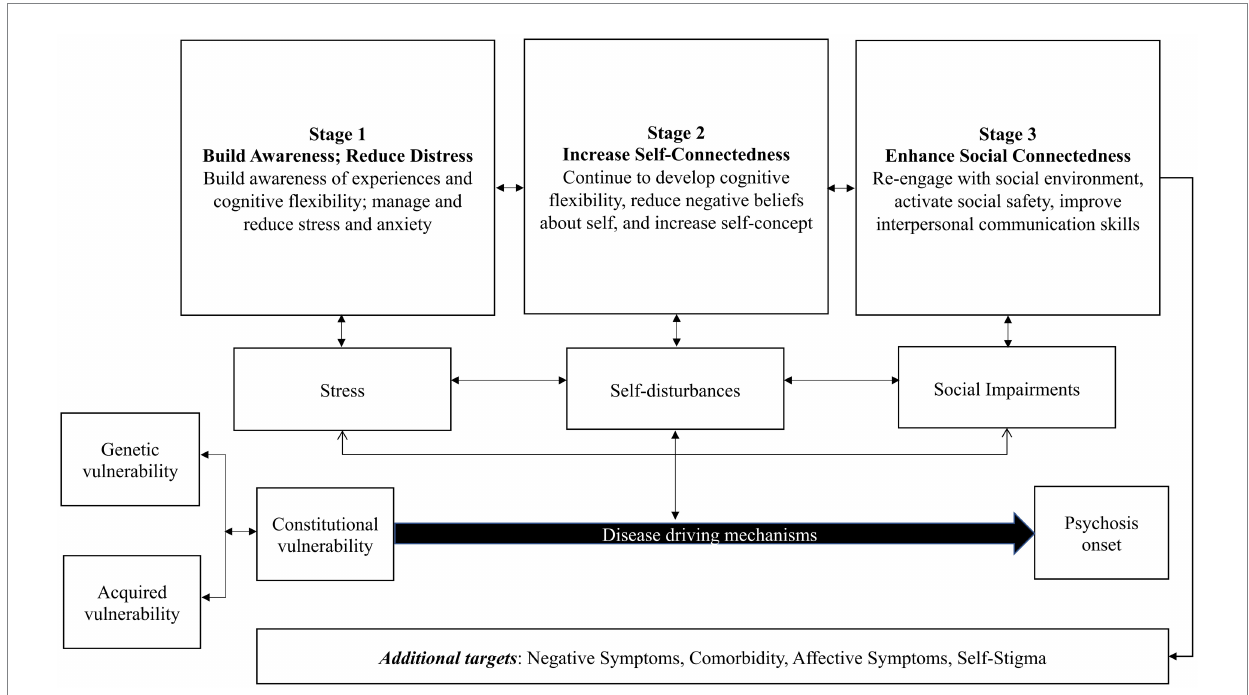
FIGURE 1 SPACE group conceptual model. The diathesis stress model posits that the onset of psychotic disorders such as schizophrenia can occur through the interaction between genetics and acquired vulnerability. This interaction can lead to a constitutional vulnerability, the diathesis, that can further interact with stress, self-disturbances, and social impairment, possible disease driving mechanisms (amongst others not listed here due to the focus of the framework). The conceptual framework suggests taking an integrative approach to group therapy by targeting stress, self-disturbances, and social impairments could be useful. Furthermore, integrating skills from standard Dialectical Behavioral Therapy [DBT; (68, 69)] such as mindfulness and distress tolerance skills (as in Stage 1 and 2), Cognitive Behavioral Therapy for those at Risk of a First Episode Psychosis [(70); as in Stage 2], and Radically Open DBT skills [(71); as in Stage 3] may address challenges with heterogeneity observed in treatment